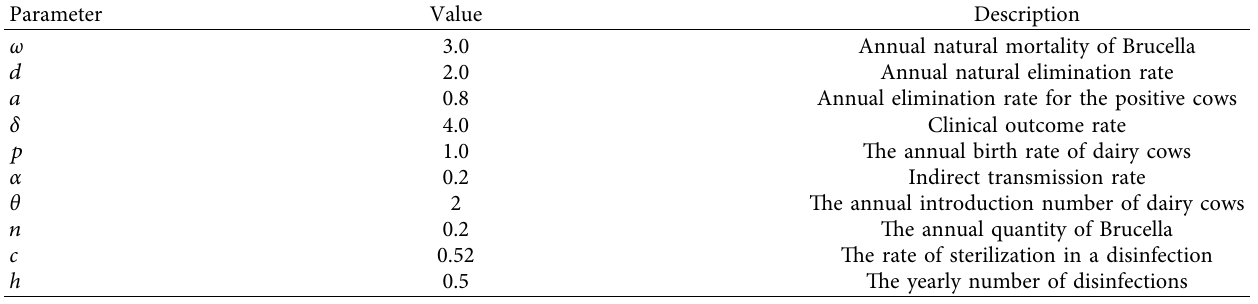
Table 1: Details of parameters [26,